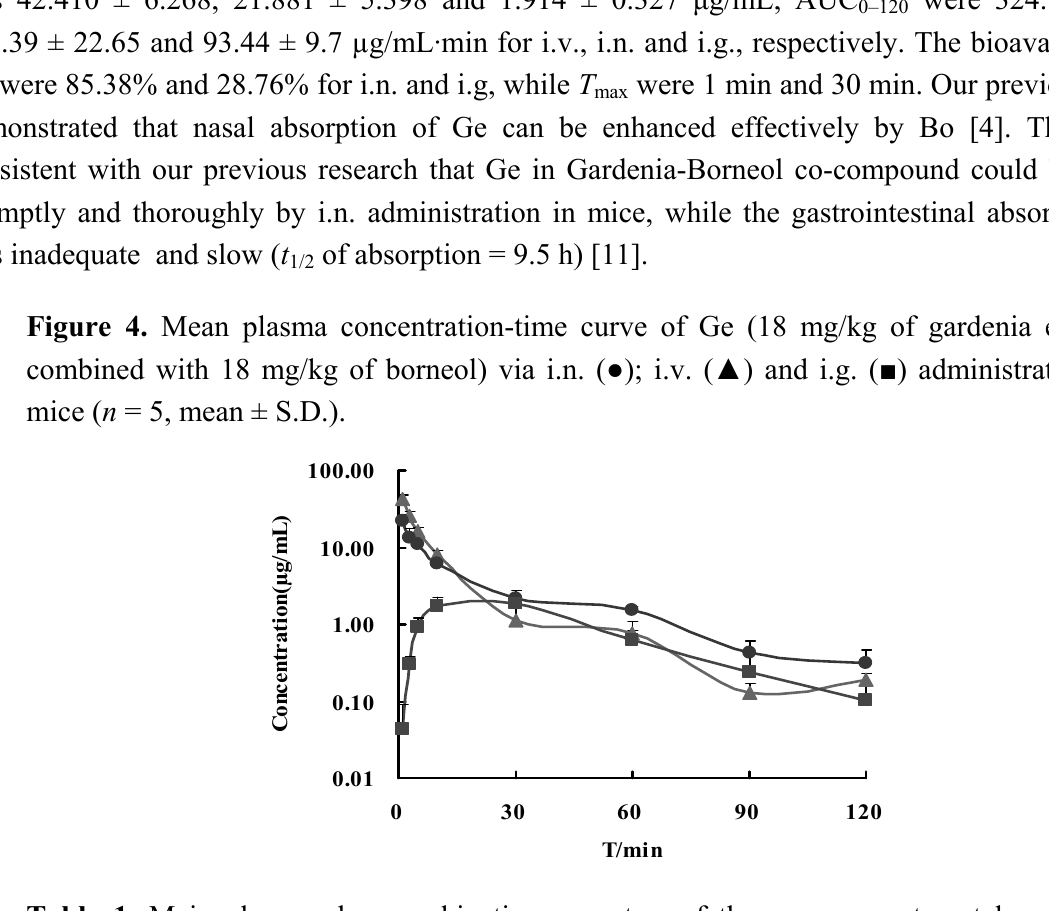
Table 1. Main plasma pharmacokinetic parameters of the non-compartmental model in mice after i.n., i.v. and i.g. administration.